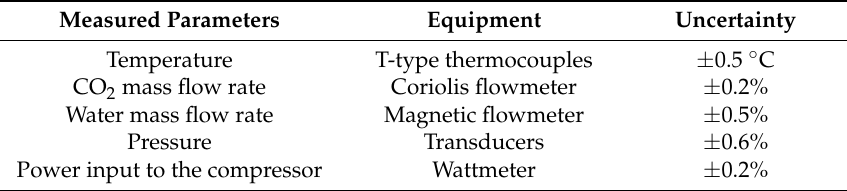
Table 5. Measurement uncertainties.